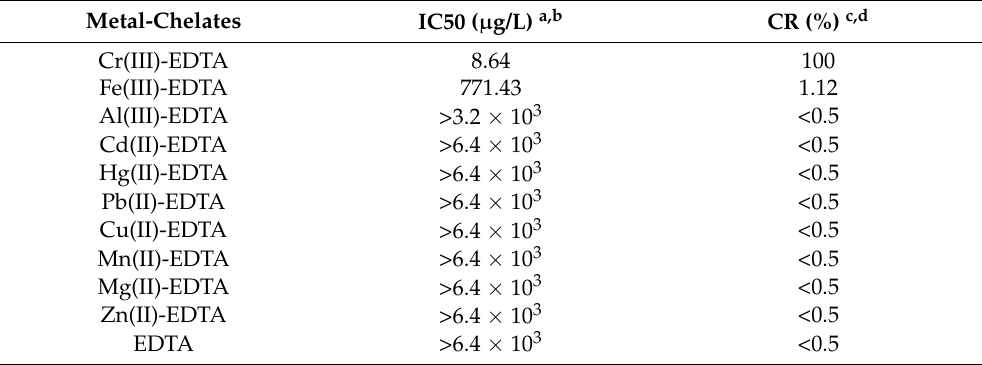
Table 3. The percent cross-reactivity of the icELISA with EDTA and other metal ions.